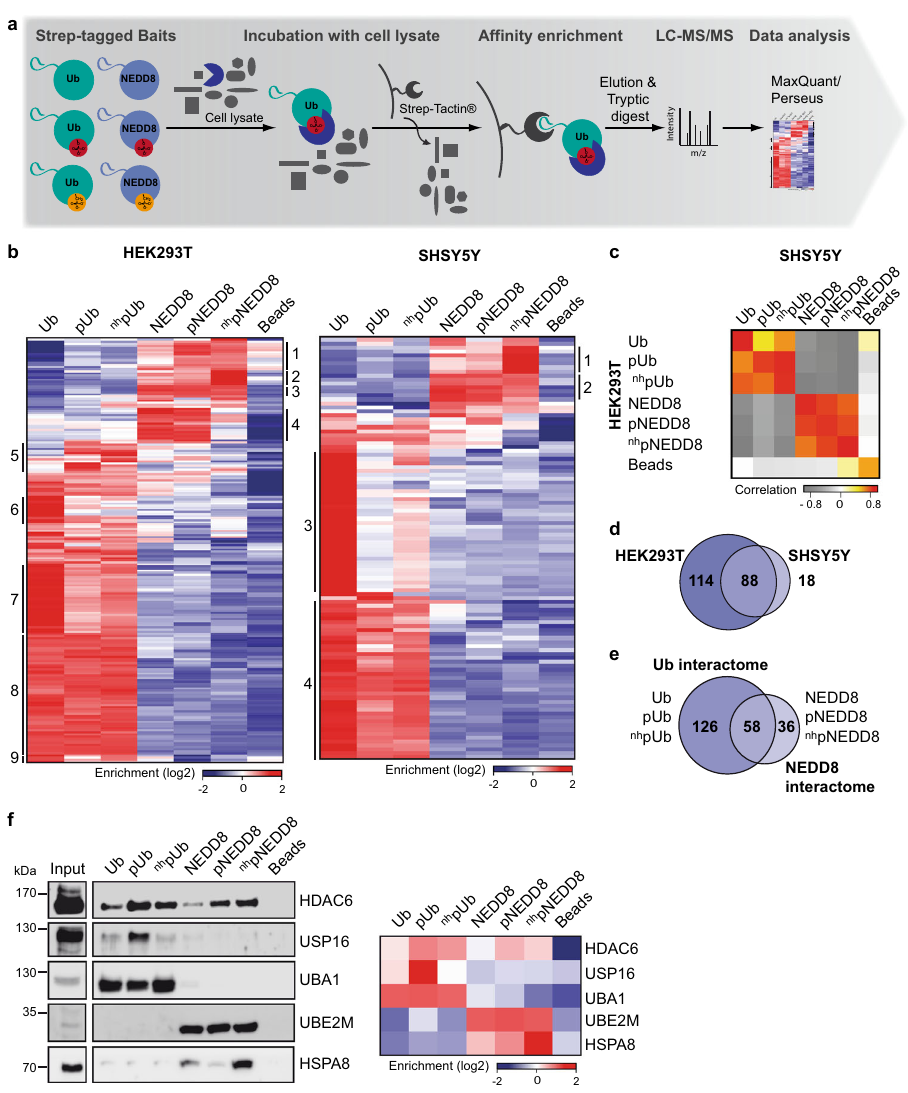
Fig. 4 Identi fi cation of the interactome of phosphorylated Ub and NEDD8. a Schematic overview of the AE-MS work fl ow for the identi fi cation of pUb and pNEDD8 interacting proteins. The bait molecules Ub, pUb, nh pUb, NEDD8, pNEDD8, or nh pNEDD8 were used as af fi nity matrices. Empty beads were used as control. n = 3 biologically independent experiments measured in technical duplicates. b Hierarchical clustering of statistically signi fi cant interacting proteins (rows) and the different bait molecules (columns) in HEK293T and SHSY5Y cell lysates. Thresholds for the ANOVA statistics were set as follows: FDR = 0.02, S0 = 1. Enrichment is indicated in red, whereas lack of enrichment is indicated in blue. Numbers of the different clusters are indicated on both sides. c Plot of the heatmap of pairwise correlation between signi fi cantly enriched interactors for each bait in HEK293T and SHSY5Y cell extracts. A strong correlation is indicated in red, medium correlation in yellow, no correlation in white and anti-correlation in grey. d Venn diagram showing the overlap of signi fi cantly enriched interactors for the pull-down performed with HEK293T and SHSY5Y cell lysates. e Overlap between the combined signi fi cantly enriched interactors of all Ub and all NEDD8 variants. HEK293T and SHSY5Y data were combined. For the heatmap of pairwise correlation between signi fi cantly enriched interactors for each bait see Supplementary Fig. 7. f Con fi rmation of interactions by Western blot analysis. 10% of the elution fraction of the af fi nity enrichment assays were subjected to Western blot analysis with antibodies speci fi c for the respective protein. Input represents 1% of the HEK293T cell lysate used for af fi nity enrichment. The Western blot shown is representative of three independent experiments. Source data are provided as a Source Data fi